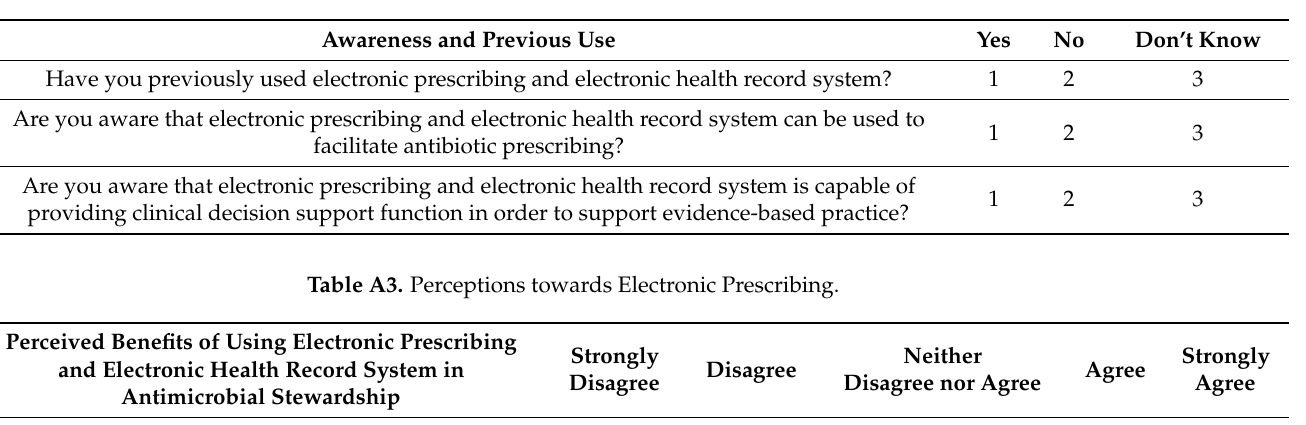
Table A2. Electronic Health Record SystemAwareness and previous use.